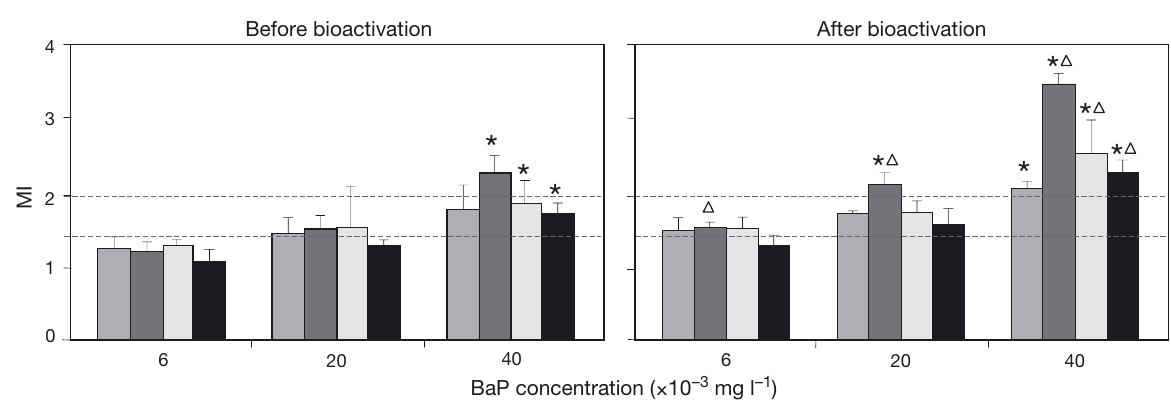
Fig. 3. Mutagenicity index (MI) of different concentrations of BaP analysed using the Vibrio harveyi test. Error bars = 1 SD. The assay was performed with 4 different bacterial strains, before and after metabolic activation with the S9 fraction from the liver of male Wistar Han rat. V. harveyi strains: BB7 ( j ); BB7M ( j ); BB7X ( j ) and BB7XM ( j ). Limits of MI values (dashed lines): potentially mutagenic (1.5 < MI < 2) and mutagenic (MI > 2).  : significant increase of MI with the BaP concentration (p < 0.05); Δ : significant increase of MI after metabolic activation (p < 0.05) (Tukey’s